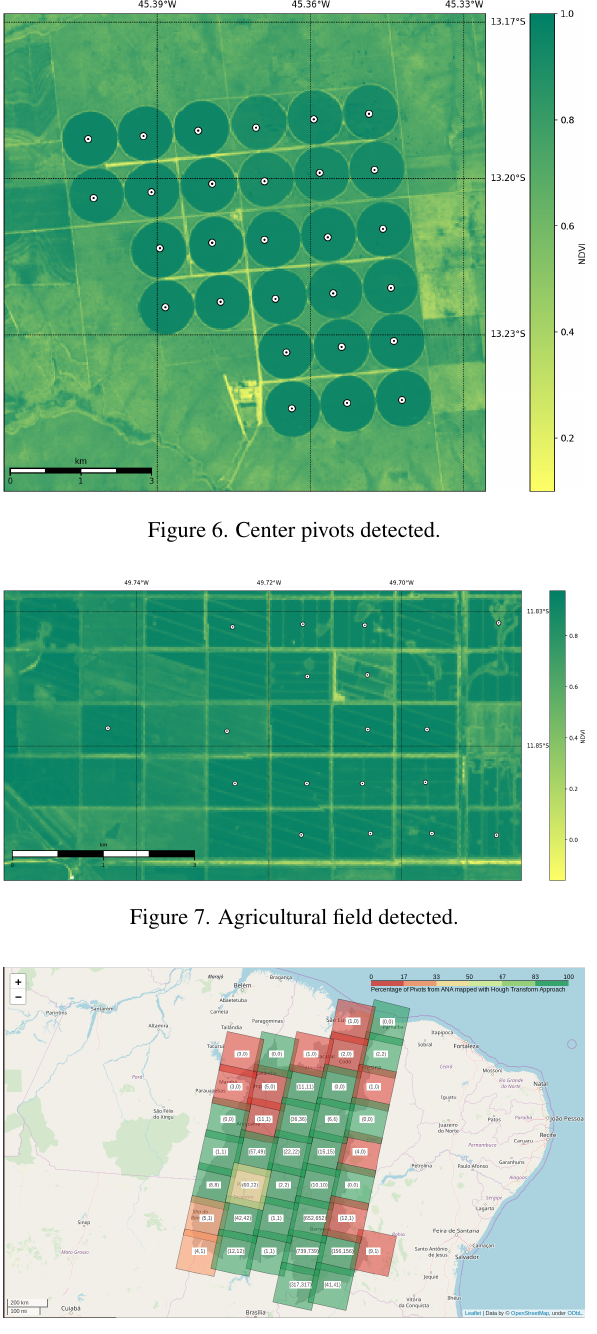
Figure 8. Potencial of pivots recovery using CHT.